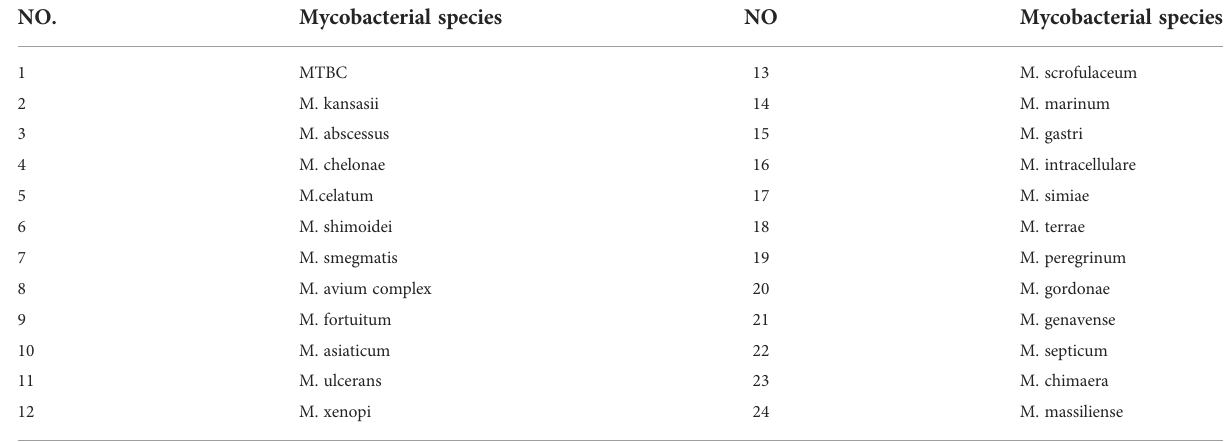
TABLE 1 The identi fi cation catalog of mycobacterial species.